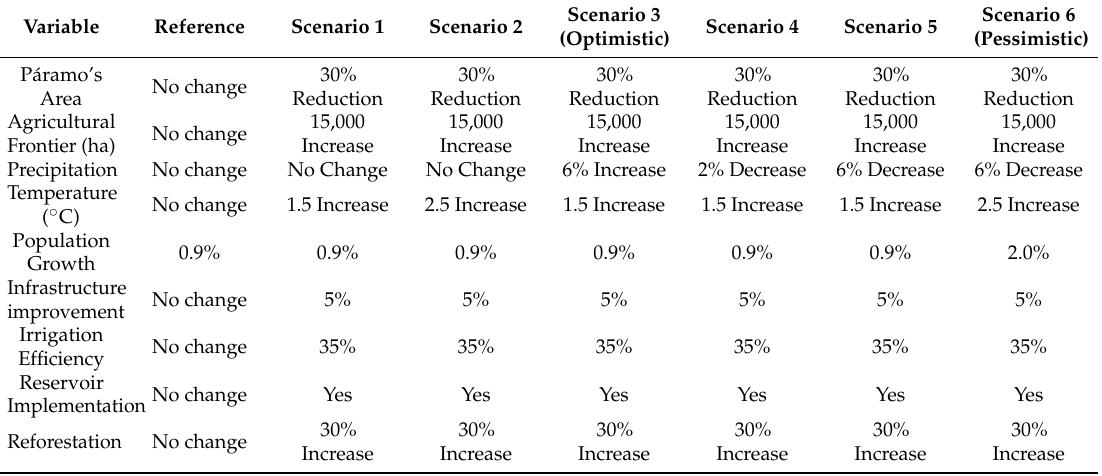
Table 4. Design of modeling scenarios on historic time series, simulated for